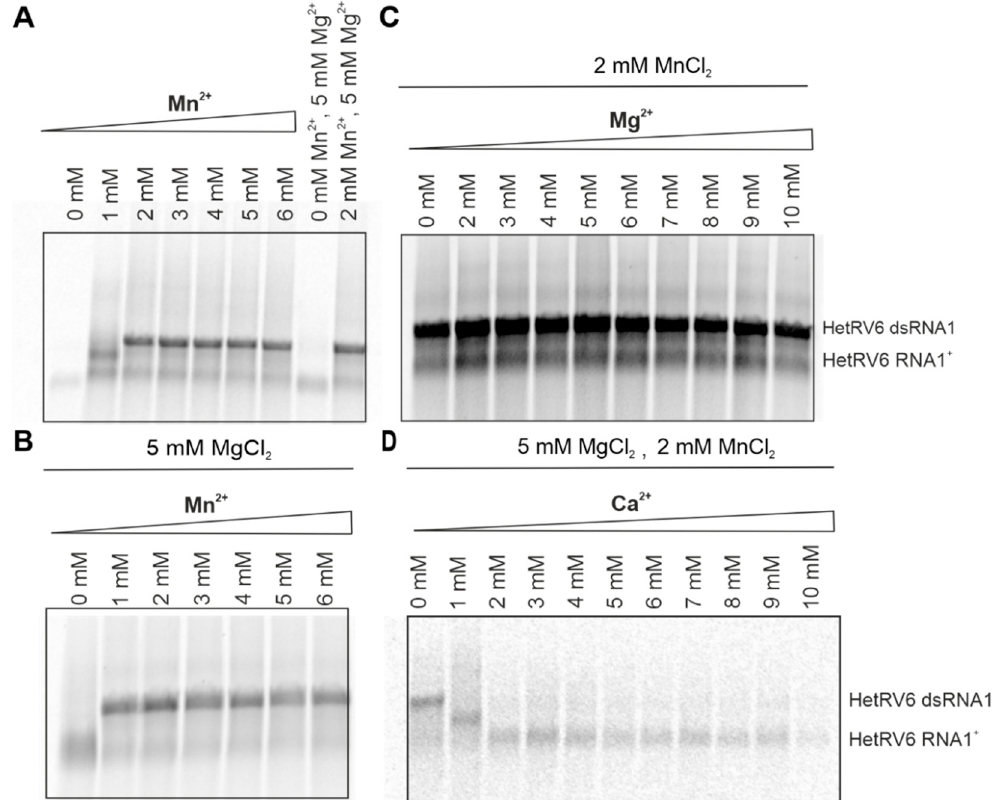
Figure 6. Role of divalent cations in dsRNA synthesis catalyzed by HetRV6 RdRp. ( A ) Buffer for the polymerase assays was prepared without addition of any divalent cations. Mn 2+ was added to a final concentration of 1–6 mM. ( B ) Standard polymerase assays were supplemented with 5 mM MgCl 2 and included variable concentration of Mn 2+ . ( C ) In the reactions containing 0 − 10 mM Mg 2+ , 2 mM MnCl 2 was added. ( D ) Reactions with 0 − 10 mM Ca 2+ contained both 5 mM MgCl 2 and 2 mM MnCl 2 . The polymerase assays were incubated at 30 °C during 1.5 h, and then analyzed on native agarose gel followed by autoradiography. The mobility of the template HetRV6 RNA1 + and the dsRNA1 product are indicated on the right.